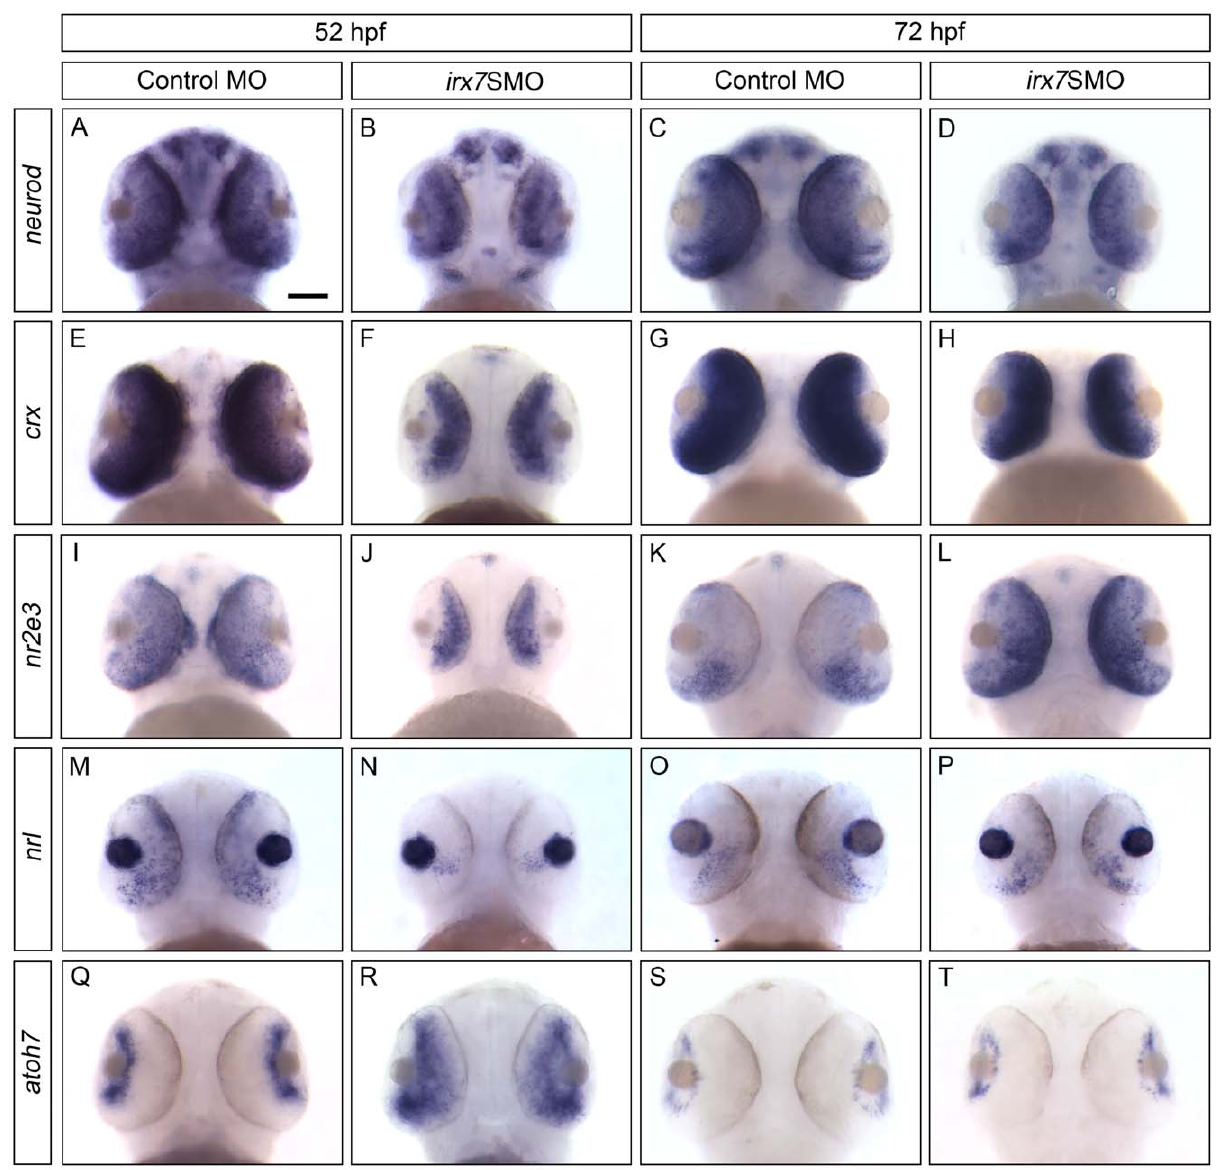
Figure 9. Irx7 regulates the expression of TFs that specify retinal cell types in ONL and GCL at 52 and 72 hpf. Whole-mount in situ hybridization of neurod (A–D), crx (E–H), nr2e3 (I–L), nrl (M–P) and atoh7 (Q–T) was conducted. The most common staining pattern is shown. Embryos were imaged from the ventral side and anterior is up. See text for further discussions. Scale bar=50 m m.